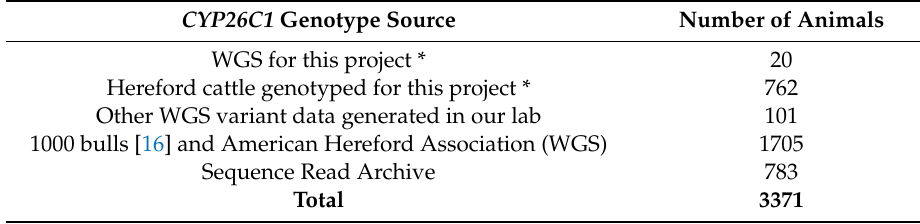
Table 4. CYP26C1 Genotyping (Chr26 g. 14404993T > C) by source.